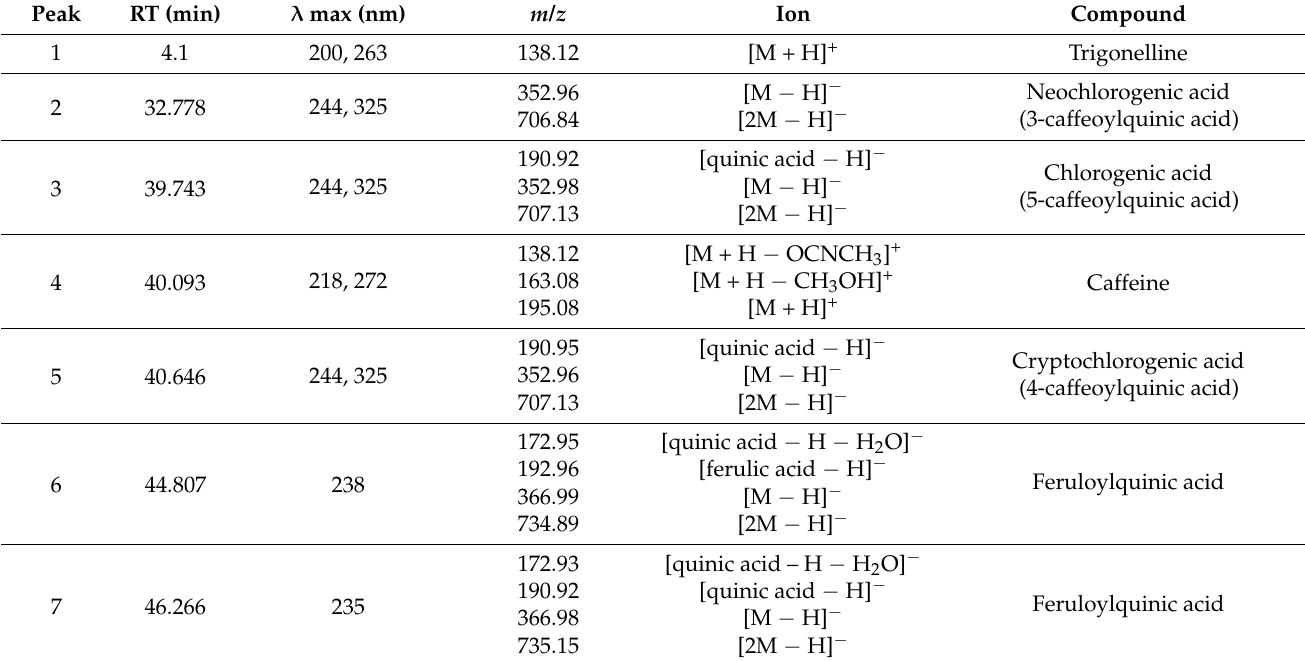
Table 2. Summary of the chromatographic, UV-vis-spectroscopic and mass spectrometric characteris- tics of the plant compounds identified in coffee charcoal extracts [22].